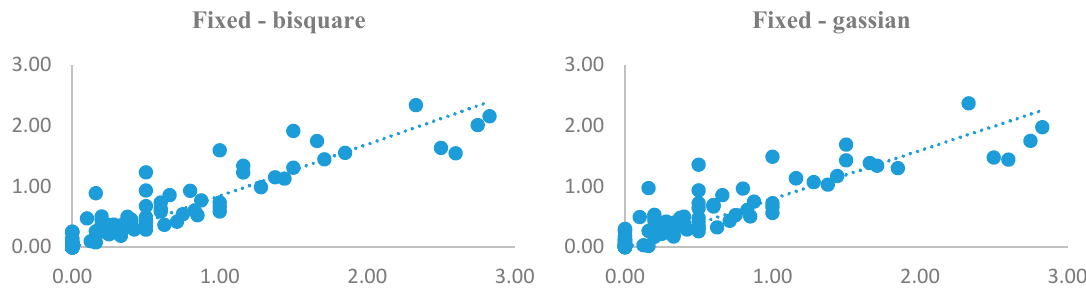
Figure 5. Scatterplots of observed and estimated values of GWR model using AIC.